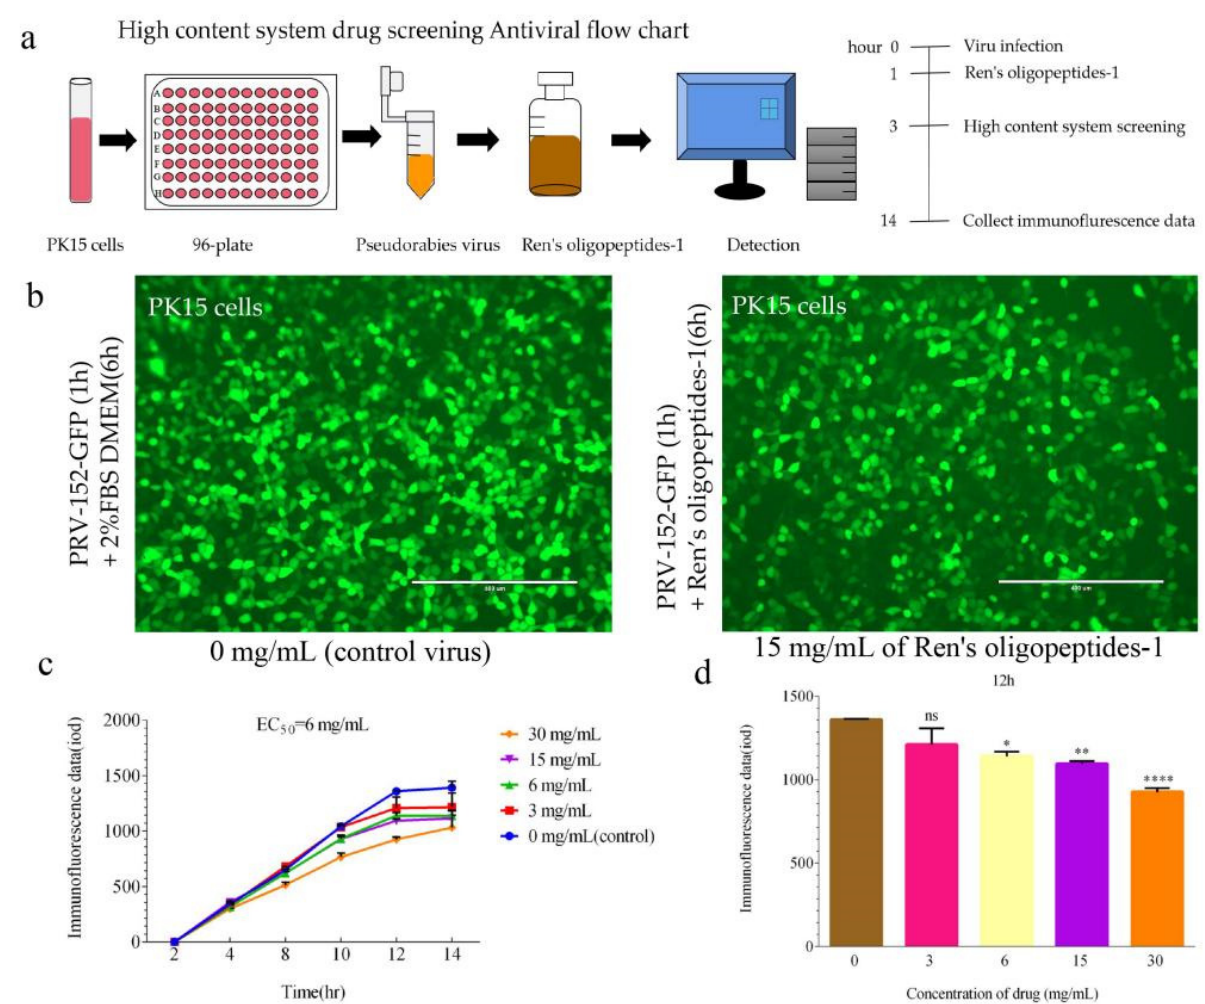
Figure 3. Ren’s oligopeptides-1 inhibits PRV-associated replication in PK15 cells. ( a ) High-content system drug screening antiviral flow chart. ( b ) Infected cells’ immunofluorescence plots were treated with 0 mg/mL and 15 mg/mL of Ren’s oligopeptides-1. ( c ) Infected cells were treated with 3